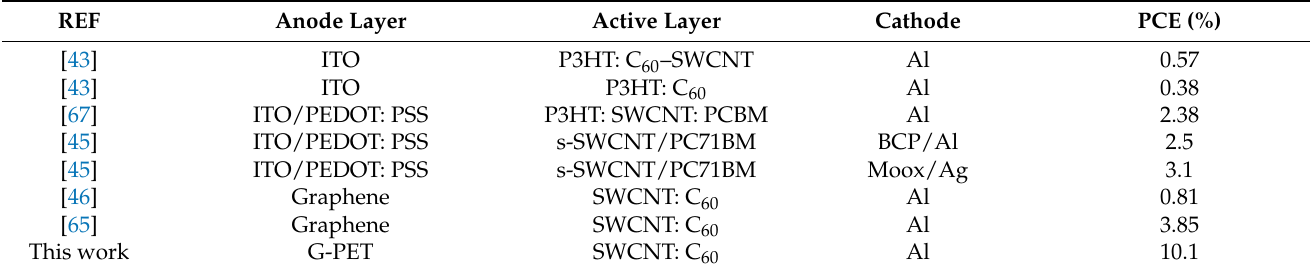
Table 7. Summary of S-SWCNT-based active layer having best PCEs employing them in OPV